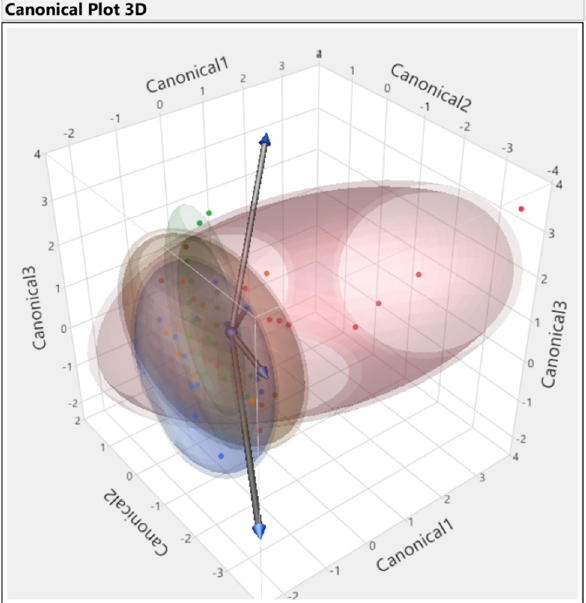
Figure 5. The 3D canonical plot of QDA results in the discrimination of four groups based on the two sets of characteristics, including Chl b , Chl total, POX, and Sod.